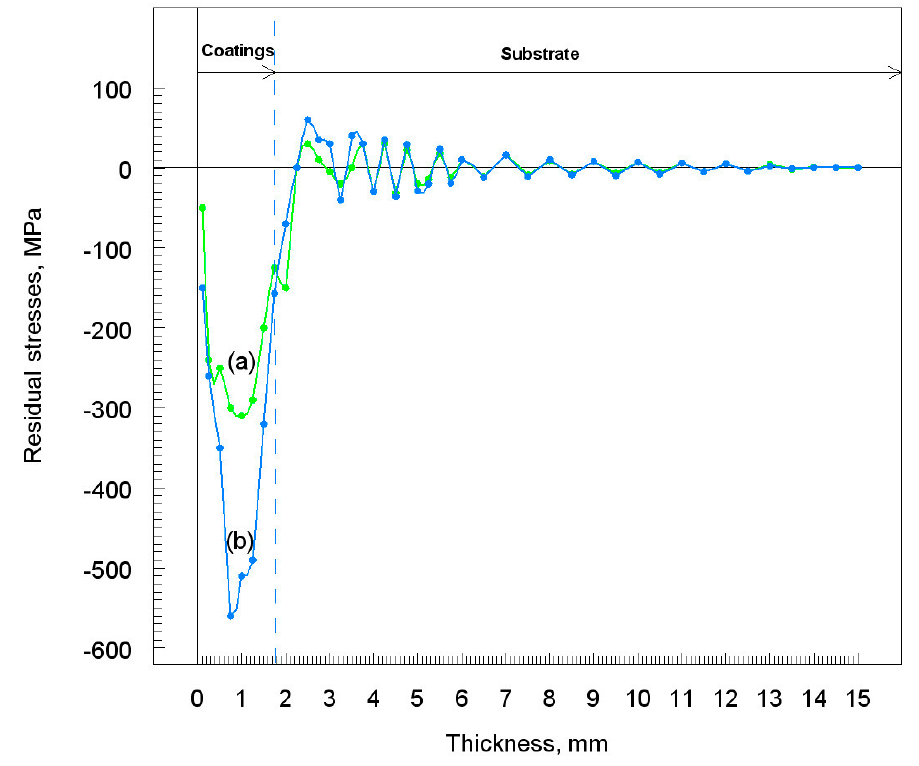
Figure 13. Residual stress profile after grit-blasting of the Al7075 substrate.